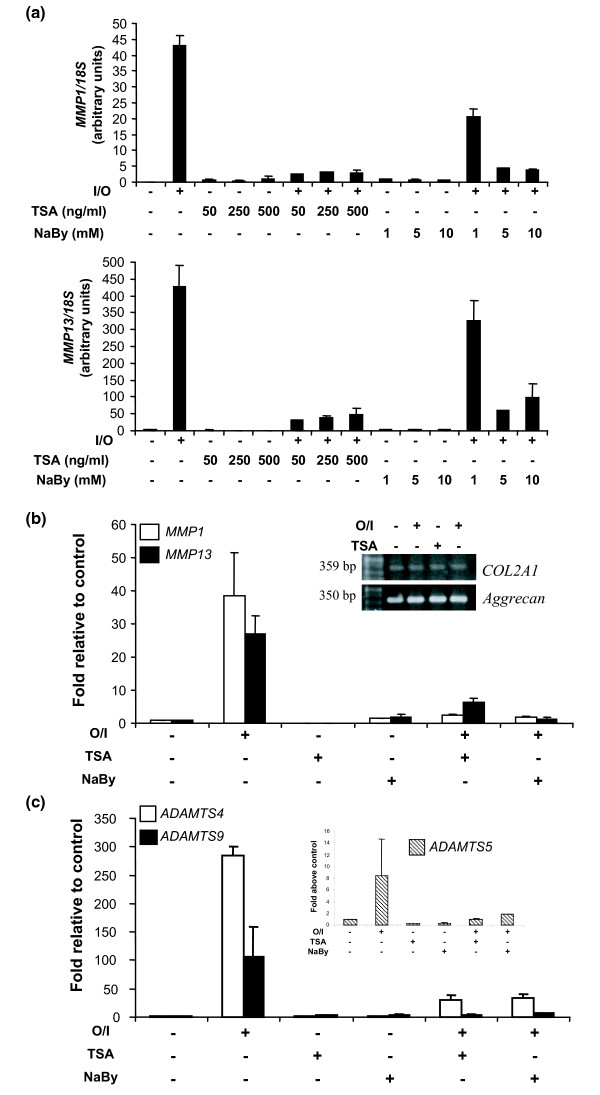
Histone deacetylase inhibitors abrogate IL-1α/OSM-induced expression of key metalloproteinase genes. Cells were starved of serum for 24 hours before stimulation with I/O, a combination of IL-1α (5 ng/ml) and oncostatin M (OSM) (10 ng/ml) for 6 hours in the absence or presence of either trichostatin A (TSA) ((a) as shown or (b, c) 500 ng/ml) or NaBy ((a) as shown; (b, c) 10 mM). Total RNA was isolated and subjected to quantitative RT-PCR for expression of the genes (a, b) MMP1 and MMP13 and (c) ADAMTS4, ADAMTS5, and ADAMTS9. Data were normalised to the 18 S rRNA housekeeping gene; means and ranges are plotted. Absolute numbers are primer/probe-set-dependent and so cannot be compared between genes. (a) SW1353 chondrosarcoma cells; (b, c) primary human chondrocytes; (b) (inset) expression of COL2A1 and aggrecan by conventional RT-PCR. I/O, O/I, a combination of IL-1α and OSM; NaBy, sodium butyrate.